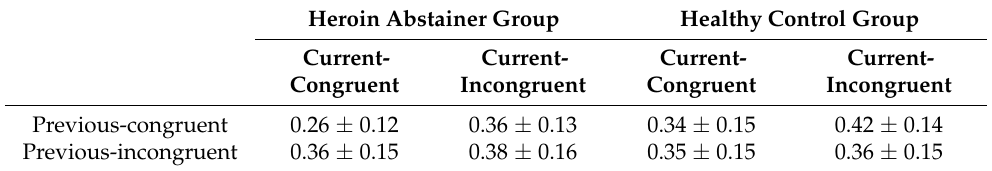
Table 2. Conflict adaptation results reflected in error